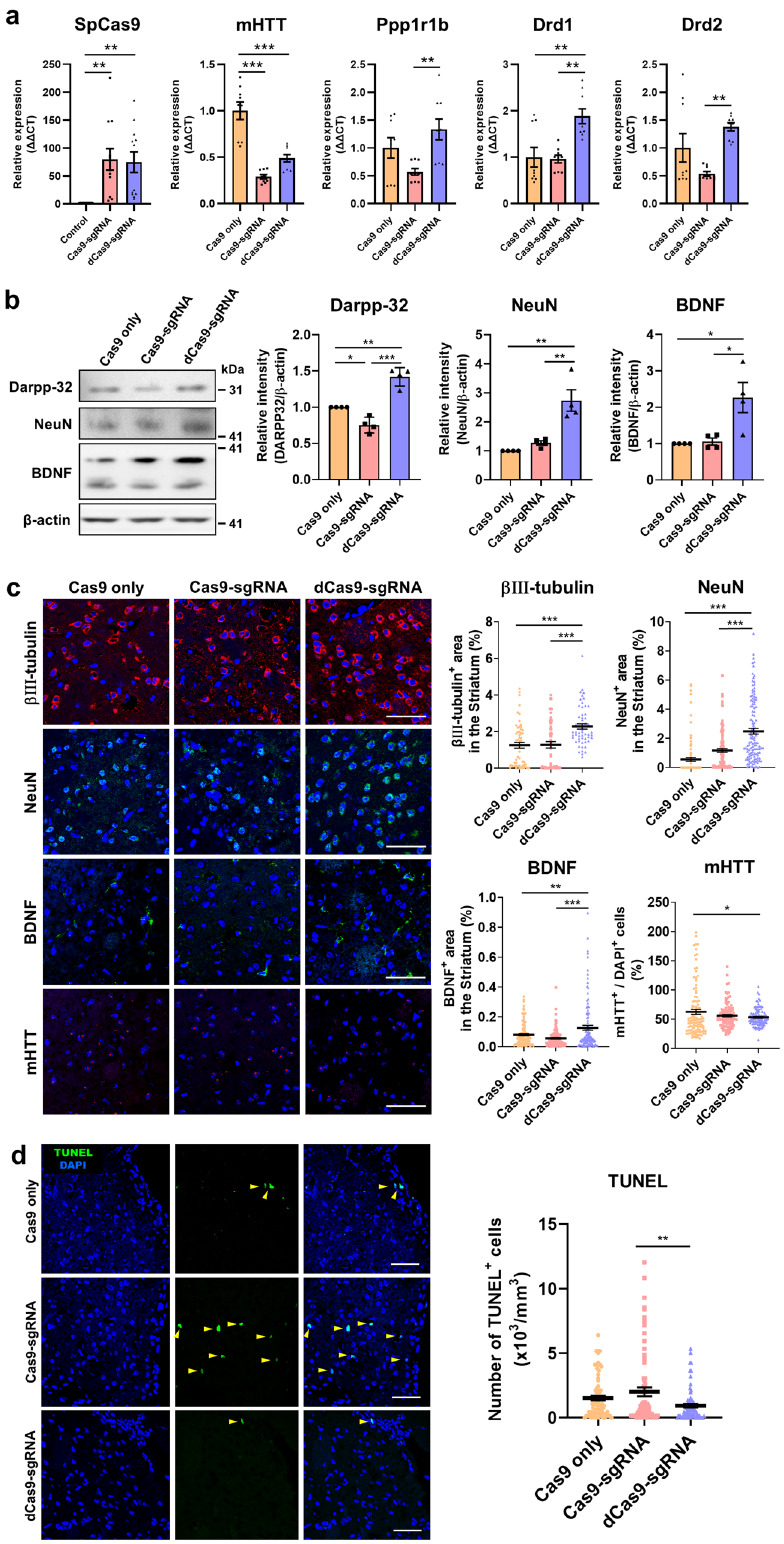
Reporter only, Cas9 only with reporter, Cas9-sgRNA with reporter or dCas9-sgRNA with reporter in HEK293T cells, showed that the number of CAG repeats was reduced only in the Cas9-sgRNA